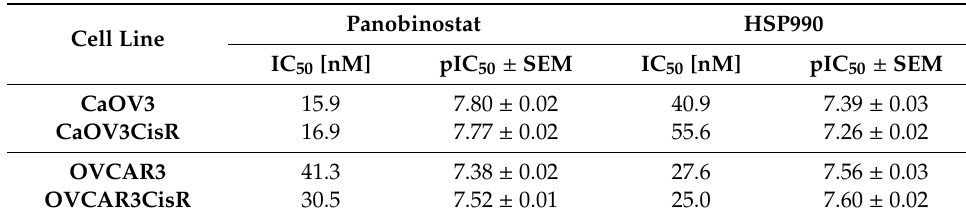
Table 3. Cytotoxic activity of panobinostat and HSP990 in sensitive and cisplatin-resistant HGSOC cell lines CaOV3 and